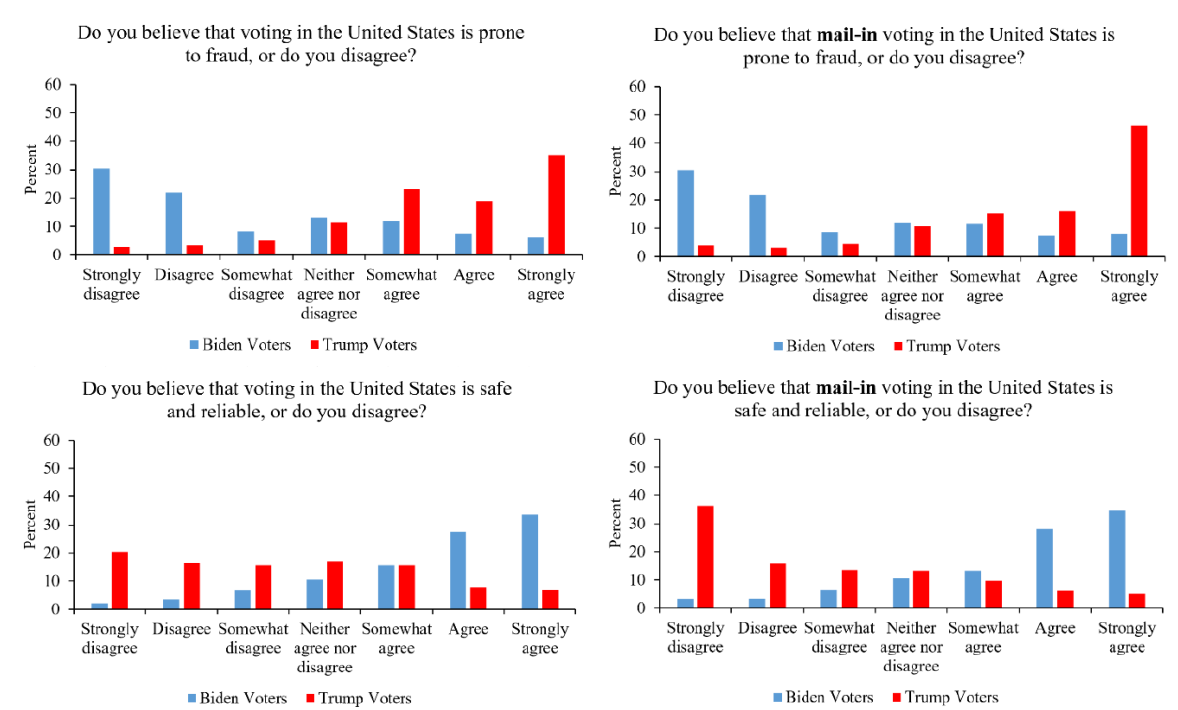
Figure 1. Belief in voter fraud . Percent of Biden (blue) versus Trump (red) voters who believe that voting (left panel) and specifically mail-in voting (right panel) is prone to fraud (top panel) or safe/reliable (bottom panel). Perhaps unsurprisingly, then, there was a large partisan divide in beliefs about the election outcome. When we asked participants to rate on a sliding scale from 0-100 who they believe won the election (0 = Definitely Biden, 100 = Definitely Trump; see Figure 1), a majority of Trump voters (65%) believe that it is more likely that Trump won than Biden and 30% believe it to be very likely that Trump won (95% or higher on the 100-point scale). Remarkably, a majority of Trump voters (67%) even believe it to be likely that Trump won the popular vote (which Trump is likely to have lost by more than 5 million votes). This was not likely due to confusion, as the survey instructions clearly distinguished the electoral college from the popular vote (see Methods). In contrast, virtually all Biden voters believed that Biden won both the election and the popular